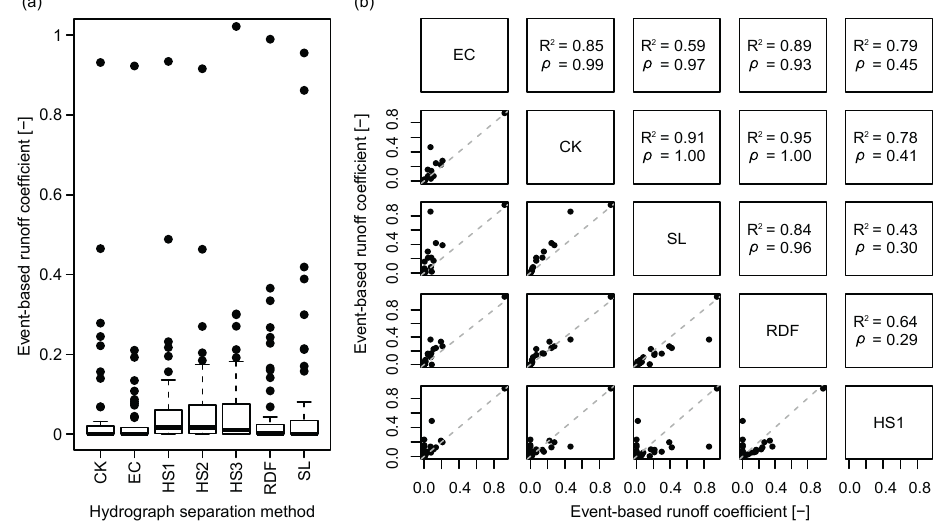
Figure 6. (a) Differences of event-based runoff coefficients φ ev calculated for 54 rain events in the Gazel catchment in autumn 2012 and autumn 2013 derived with different methods for hydrograph separation. (b) Correlation between different methods. The upper panel gives the coefficient of determination ( R 2 ) and Spearman’s rank correlation coefficient ρ , the dashed line in the lower panel is the line of identity. The methods used for hydrograph separation are described in Sect. 2.5.2: constant- k (CK), electric conductivity (EC), Hysep filter with fixed or sliding interval (HS1–HS2), Hysep filter with local minima algorithm (HS3), recursive digital filter (RDF) and straight line (SL).